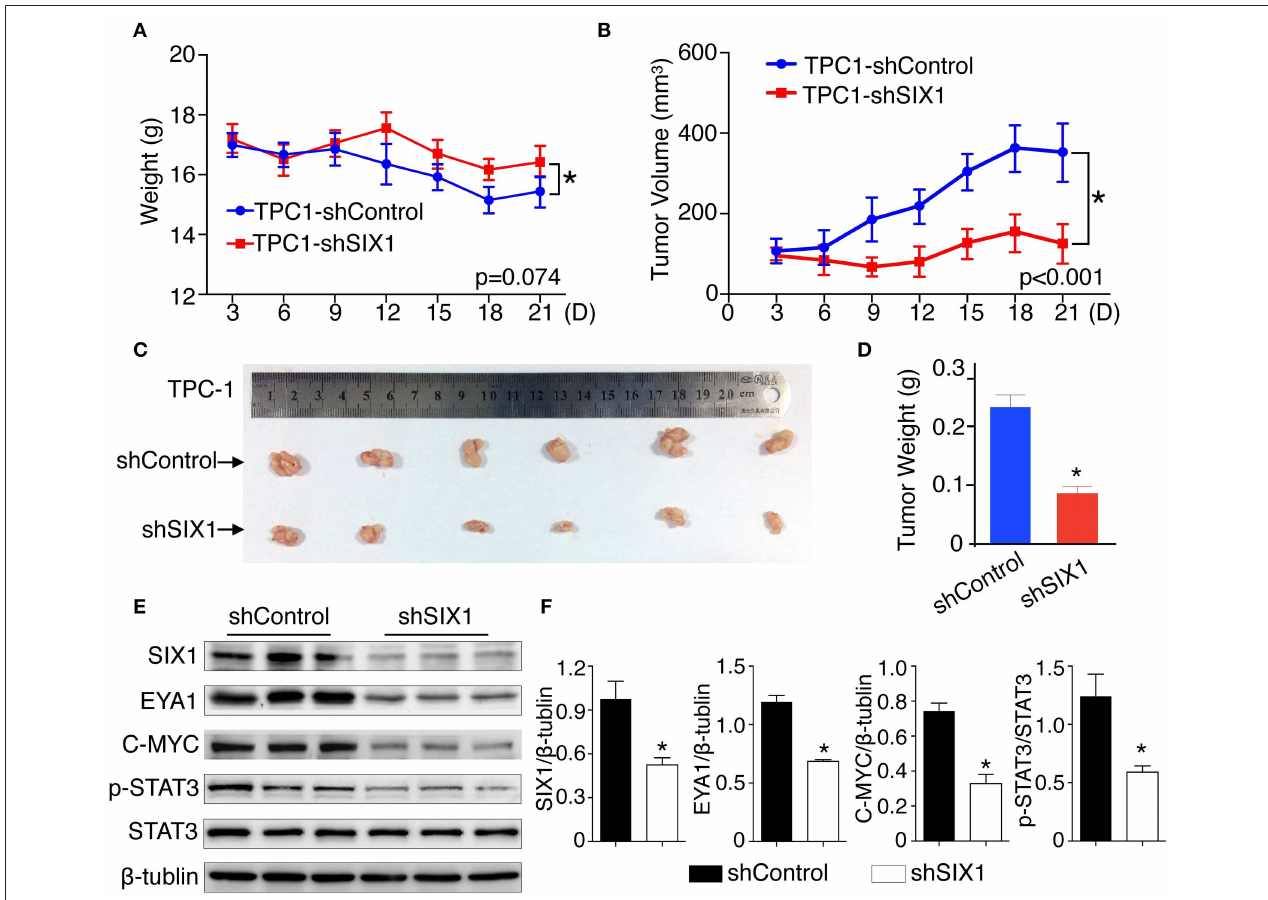
FIGURE 7 | Silencing SIX1 suppressed tumor growth as well as STAT3 signal in vivo . TPC-1 cells with SIX1 silencing or vector control were implanted into immunodeficiency mice, the body weight (A) and tumor volume (B) was monitored ( n = 20). Representative tumor image (C) and quantitative analysis ( n = 20) (D) were showed. Western blot analysis of total protein from tumor tissue (E) and relative quantitative analysis ( n = 3) (F) . * p <